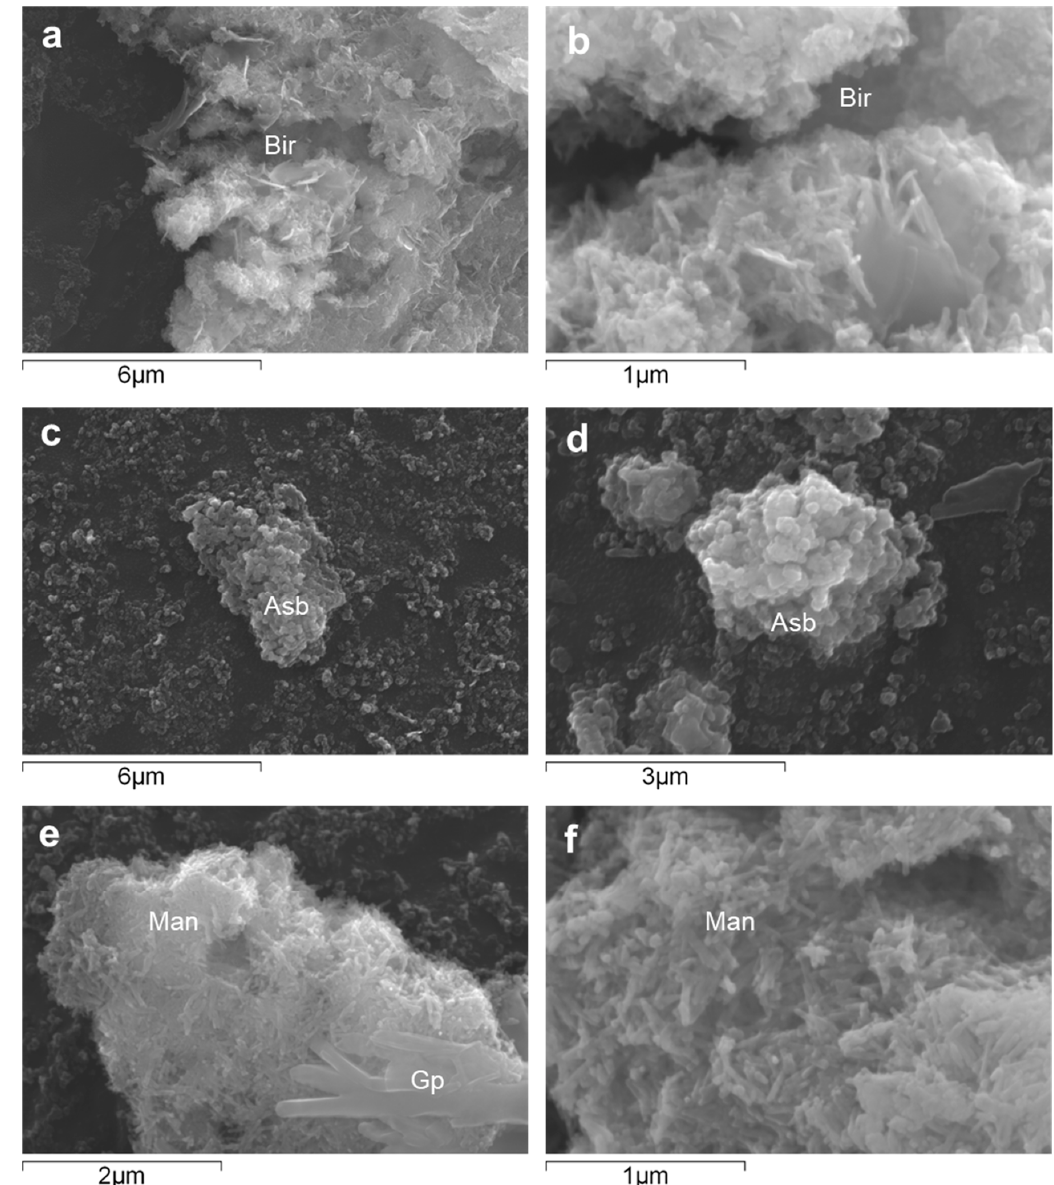
Figure 3. SEM images of Mn oxides formed during oxidation of Mn(II) in controlled experiments with mine waters from Guadiana mine ( a,b ), La Zarza mine ( c,d ), and Brunita mine ( e,f ). Mineral abbreviations: Bir, Birnessite; Asb, Asbolane; Man, Manganite; Gp, Gypsum.